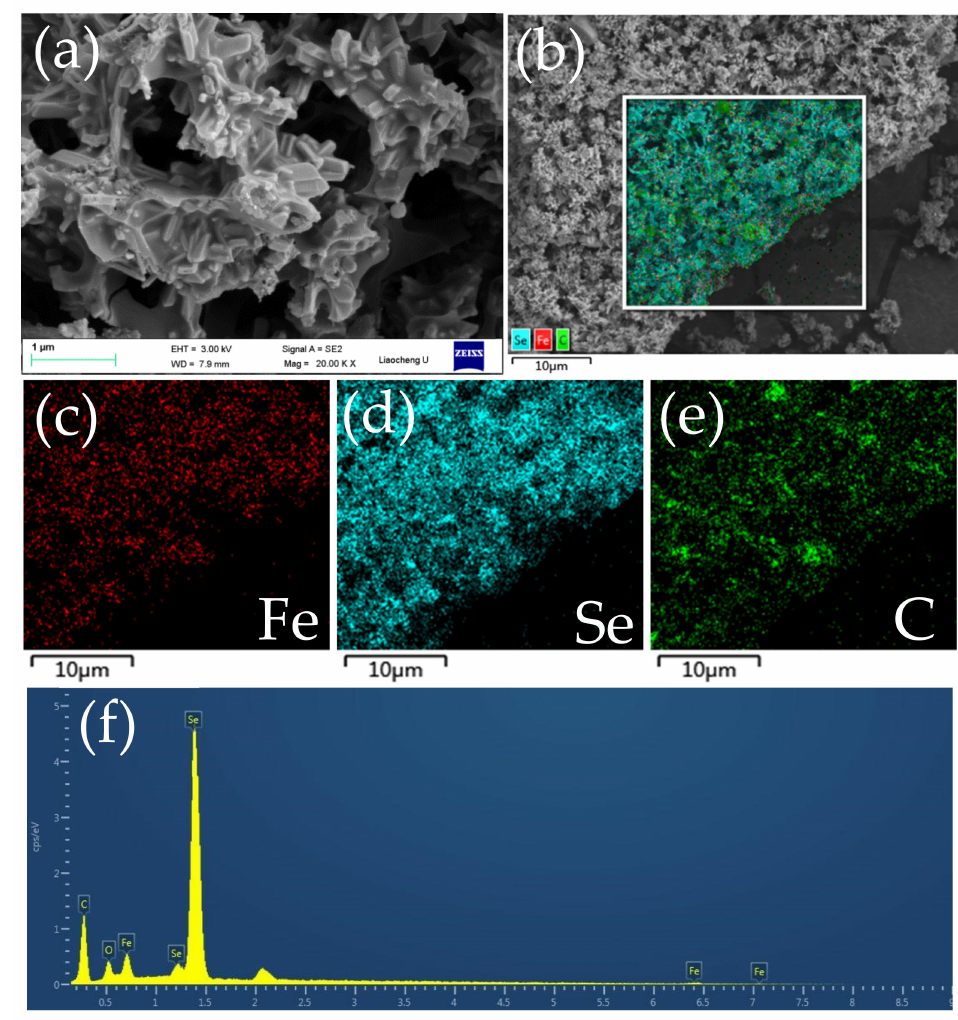
Figure 4. Fe 2 O 3 @C composite: ( a ) SEM image, ( b ) EDS hierarchical image, ( c – e ) EDS spectrum with elemental mapping; ( f ) total surface spectrum.